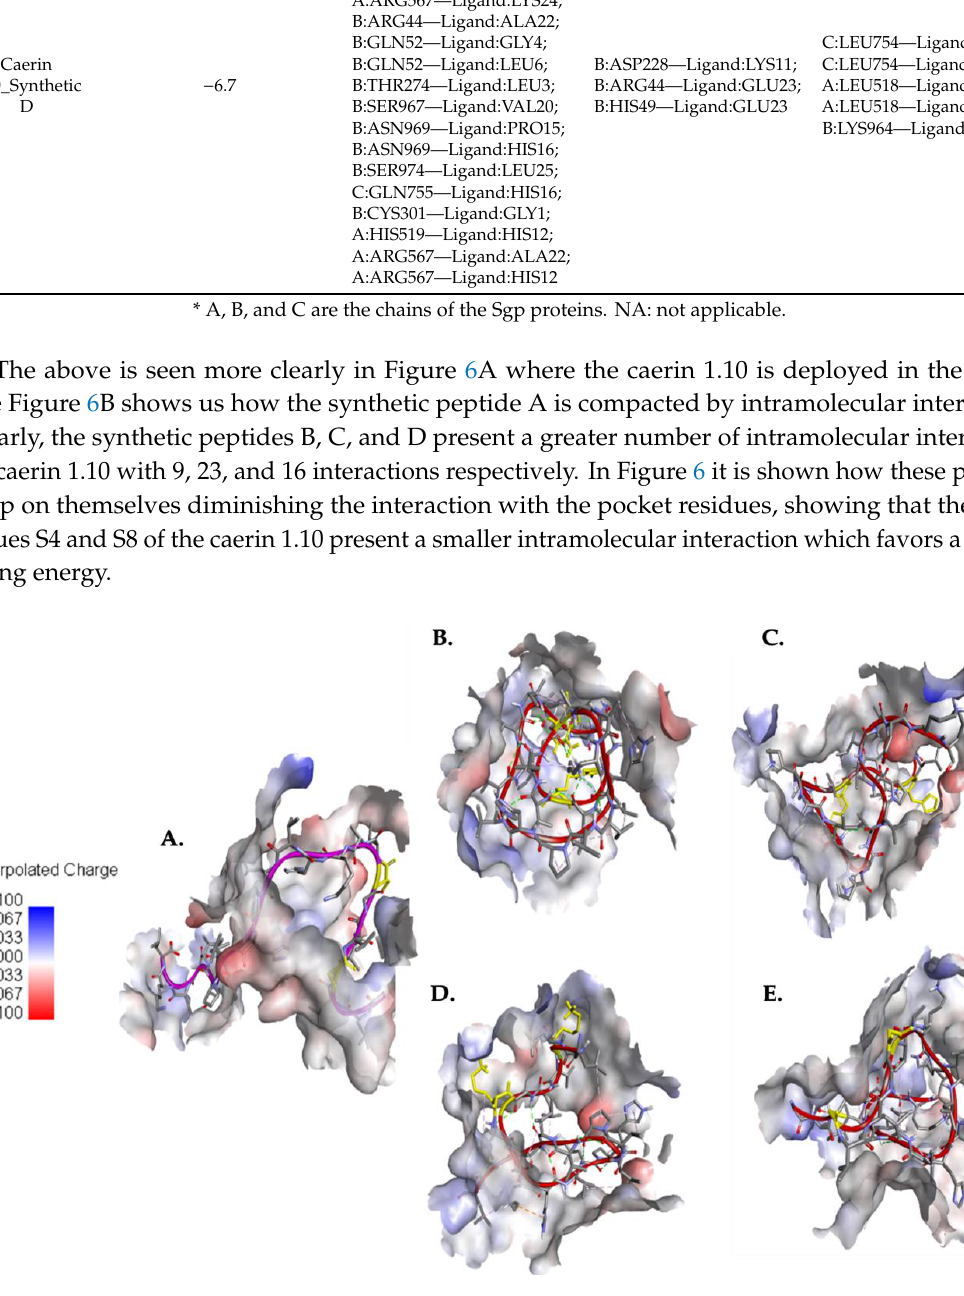
Figure 6. Comparison of the structure and intramolecular interactions between caerin 1.10 and modified caerins. ( A ) caerin 1.10, SER4 and SER8 are highlighted in yellow color; ( B ) caerin 1.10 modified A (SR3-SR8), ARG4 and ARG8 are highlighted in yellow color; ( C ) caerin 1.10 modified B (SH3-SH8), HIS4 and HIS8 are highlighted in yellow color; ( D ) caerin 1.10 modified C (SK3-SK8), LYS4 and LYS8 are highlighted in yellow color; ( E ) caerin 1.10 modified D (SG3-SG8), GLY4 and GLY8 are highlighted in yellow color.